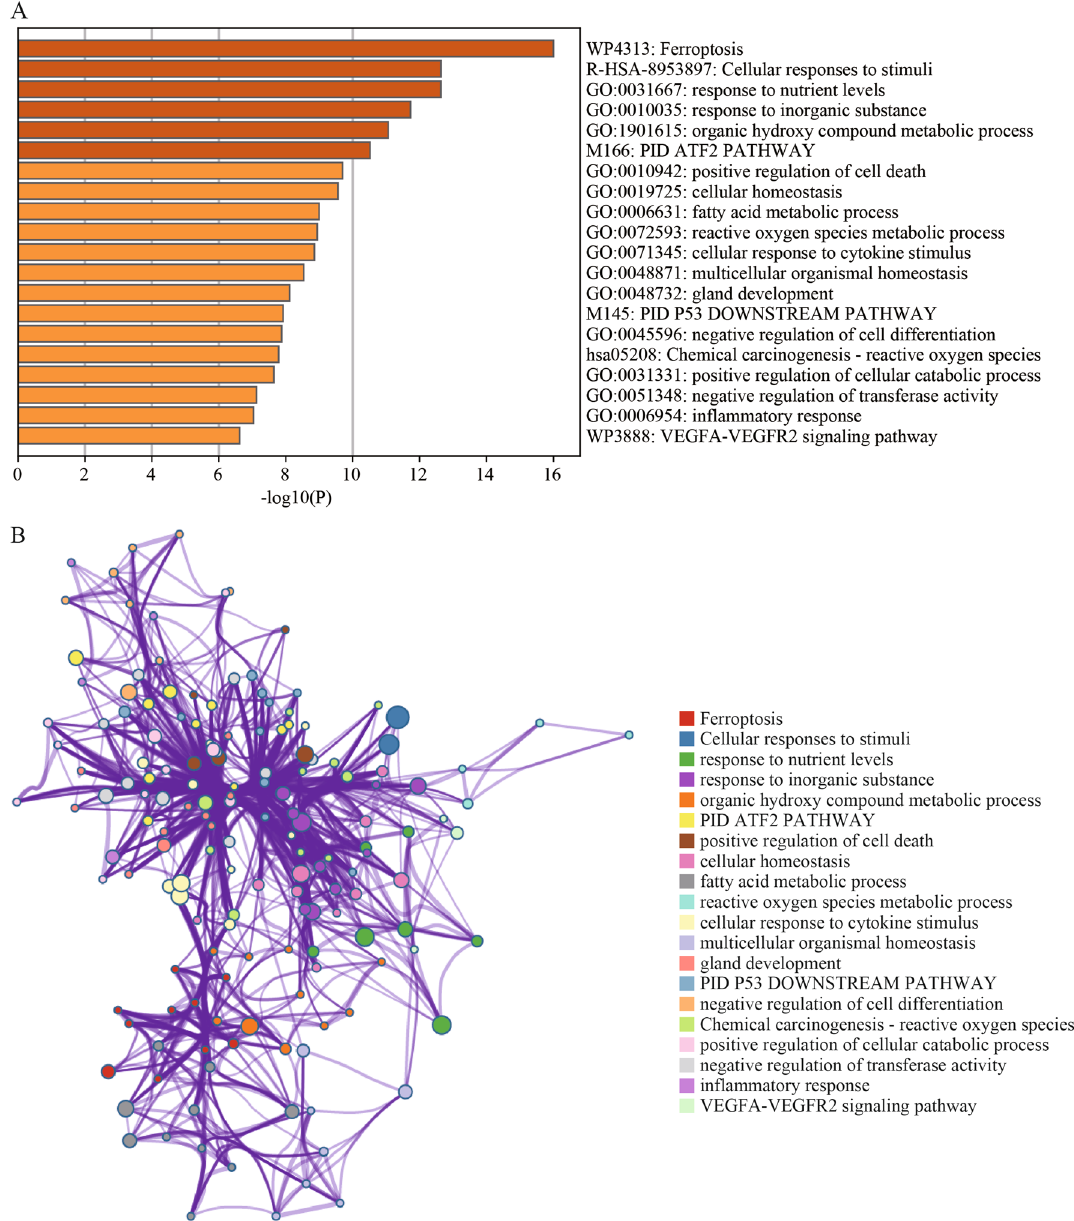
Figure 2. The functional and pathway enrichment analysis of 61 differentially expressed ferroptosis-related genes. ( A ) The top 20 enriched ontology clusters. The abscissa represents the significant P value of enrichment. The color represents the P value, and darker colors indicate smaller P values. ( B ) Network of functional and pathway enrichment terms. Each node represents an enriched term and is colored by its cluster ID. Those nodes that share the same cluster ID are generally close to each